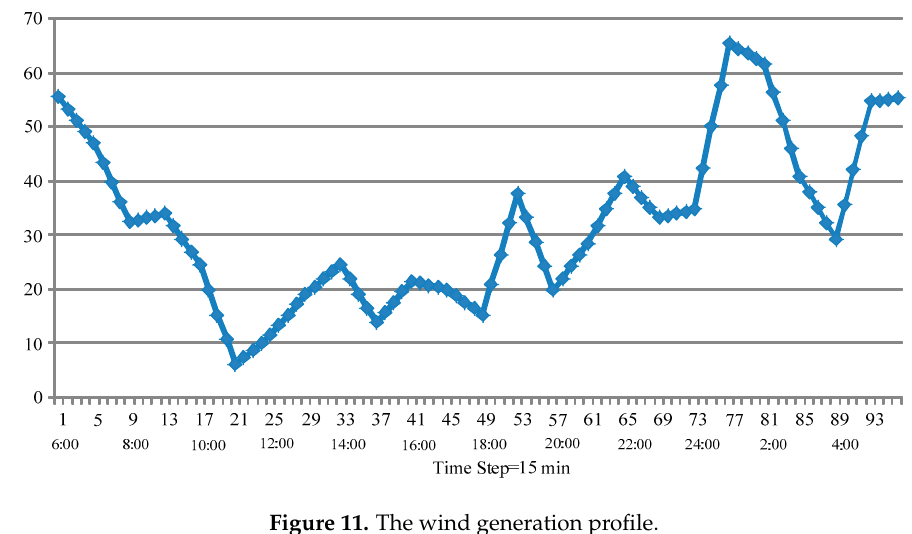
Figure 11. The wind generation profile. Table 4. Controlled charge and uncontrolled charge planning considering the integration of wind generation.